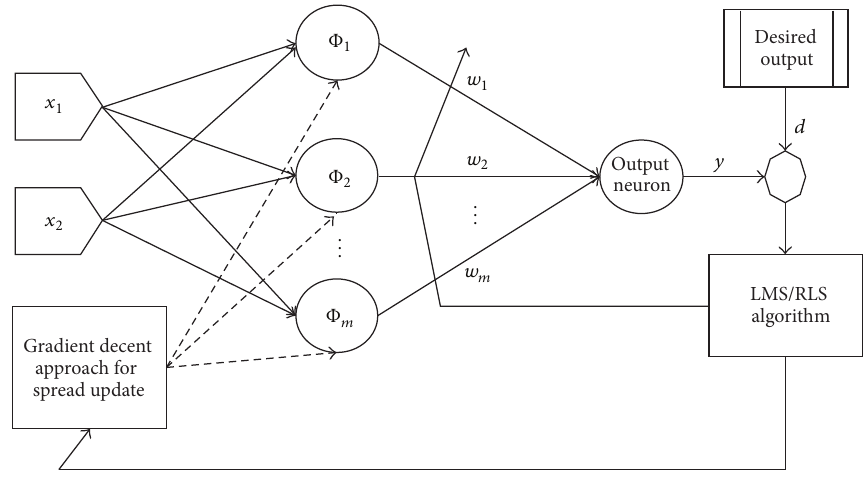
Figure 3: LMS, RLS, and adaptive spread factor ( 𝜎 ) modelled using